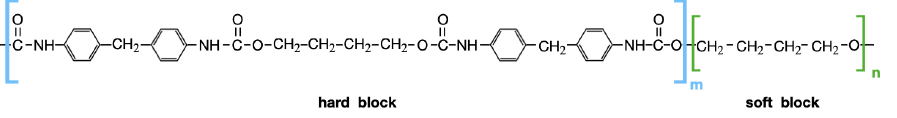
Figure 2. Chemical structure of TPU used in the MD simulations.